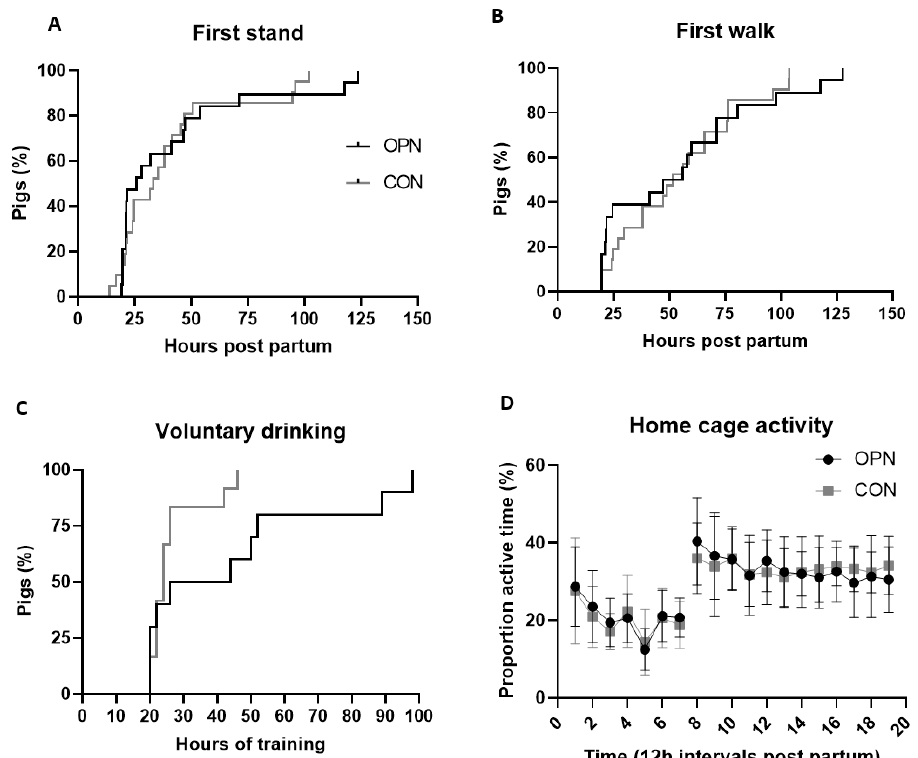
Figure 6. Early motor development, indicated by the time to first stand ( A ), first walk ( B ), first voluntary intake of a full milk bolus ( C ) and the proportion of active time during an hour averaged over 12 h intervals from Days 1–11 ( D ), of preterm pigs fed a bovine milk diet (CON, n = 12–21) supplemented with bovine milk osteopontin (OPN, n = 10–19). Data are expressed as mean ± SD. pp, postpartum.